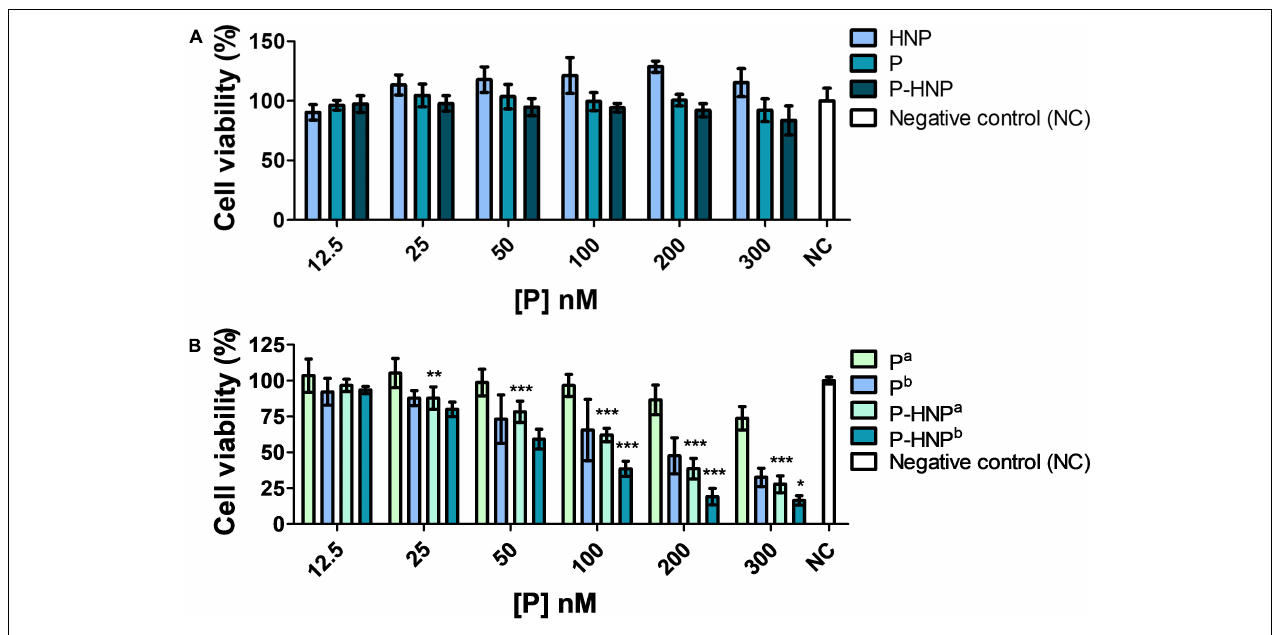
FIGURE 5 | Cell viability of T24 assessed by resazurin. (A) Cytotoxicity of hybrid nanoparticles ( HNP ), free porphyrin ( P ), and immobilized porphyrin on hybrid nanoparticles ( P-HNP ) after 24 h of treatment in the dark conditions. (B) Phototoxicity of free porphyrin ( P ) and porphyrin immobilized on hybrid nanoparticles ( P-HNP ) after 24 h of treatment followed by laser irradiation. a 5 and b 10 J/cm 2 dose of light. Negative control (NC)-untreated cells (cells + RPMI medium). The results are presented as mean ± SD of three independent experiments performed in triplicate. Significant differences relative to P and P-HNP , in each photoinduction dose, are indicated with an asterisk. Statistical significance: *** p < 0.001, ** p < 0.01, * p < 0.05. Data obtained by two-way ANOVA analysis followed by Bonferroni post-test.